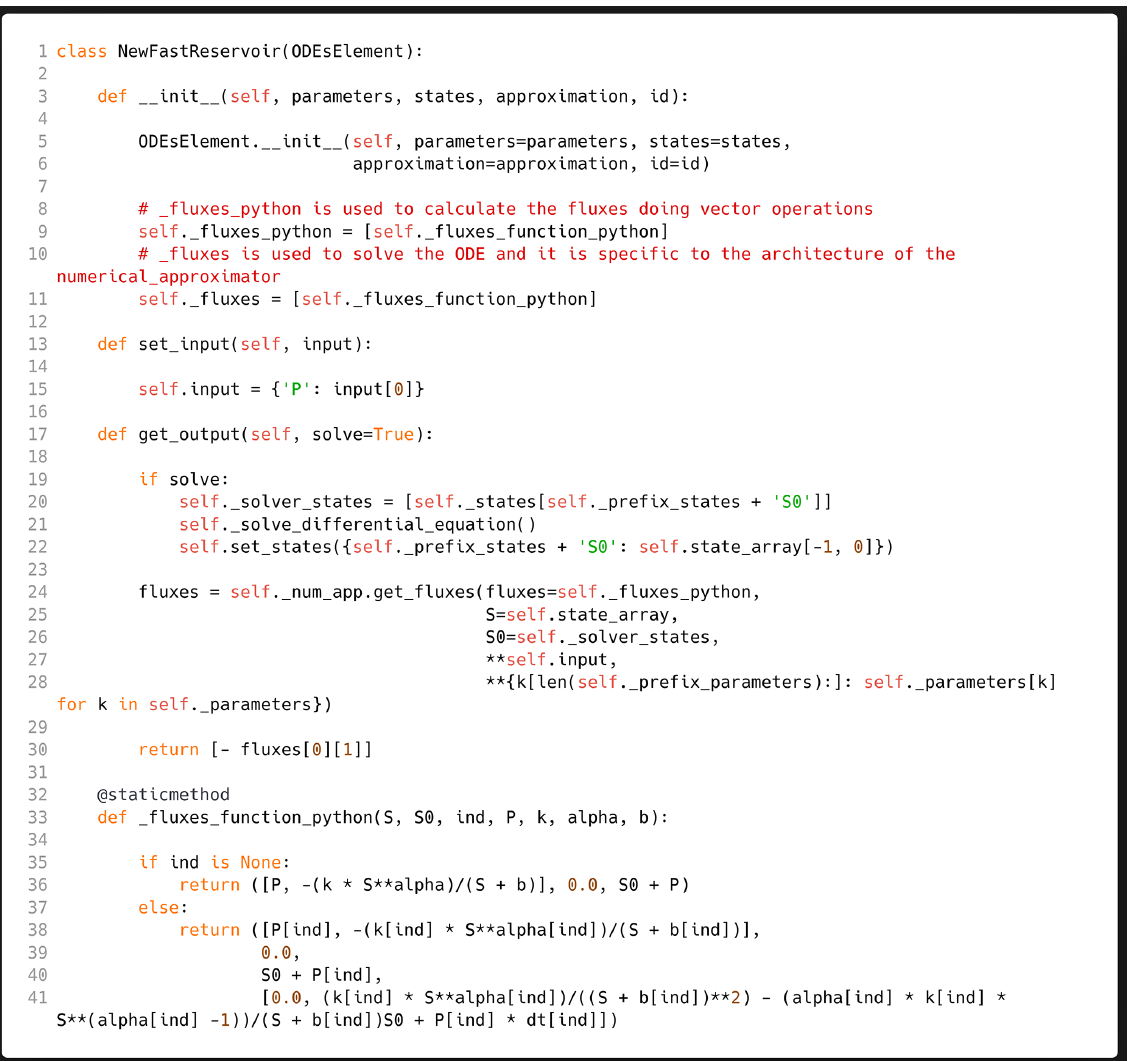
Figure 5. General approach for implementing a new reservoir element NewFastReservoir by extending the class ODEsElement (Sect.